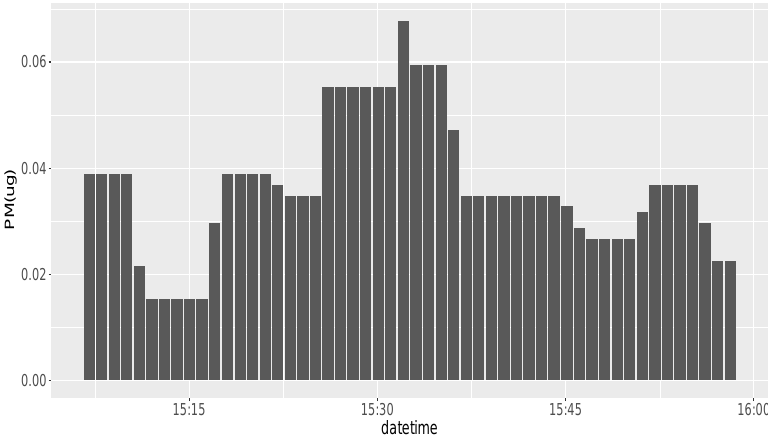
Figure 7. One Day PM 2.5 Exposure by Activity Type Percentage.